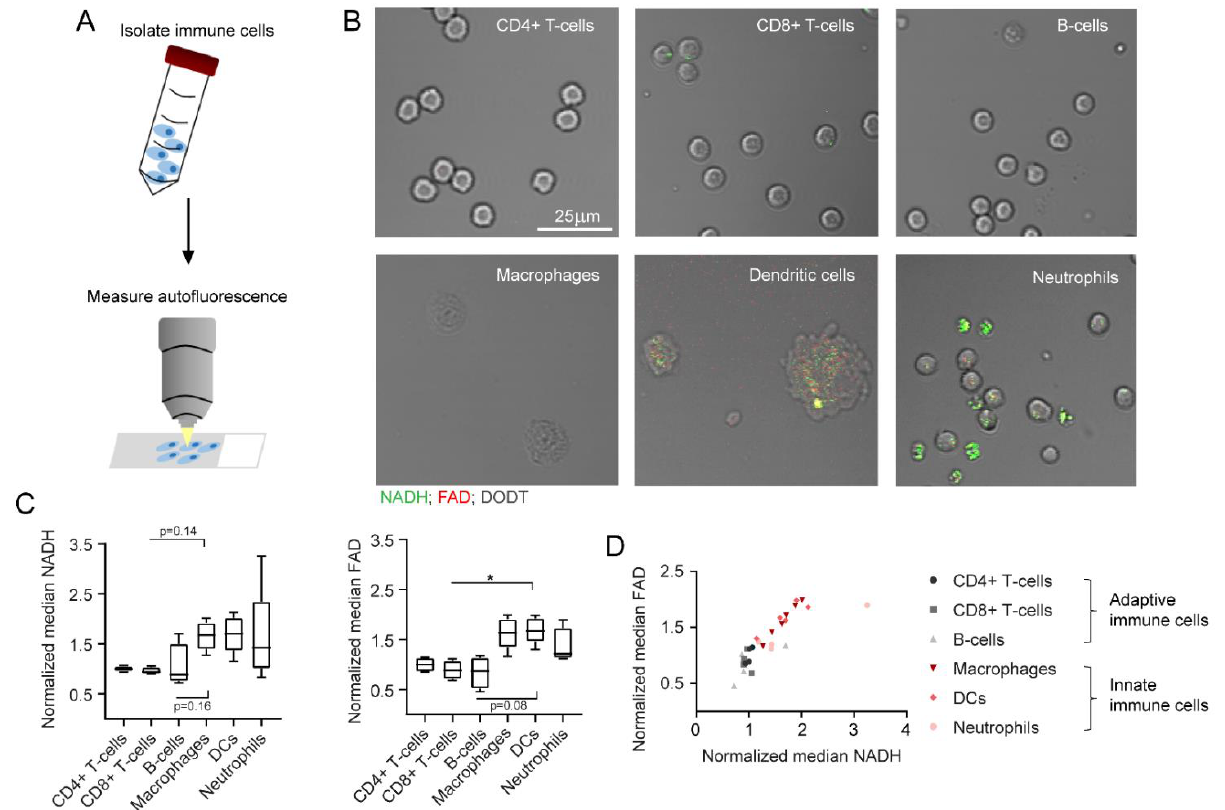
Figure 4. NADH and FAD autofluorescence changes as measured in multiphoton microscopy. ( A ) Schematic representation of MPM measurements after immune cell isolation from murine spleen and bone marrow. ( B ) Exemplary images of different immune cell types, as measured in MPM. NADH: green, FAD: red, DODT: grey (scalebar: 25 µm). ( C ) Median NADH and FAD signals of different immune cells, normalized to NADH and FAD signals of alive, unstimulated CD4+ T cells. For statistical analysis, a Kruskal – Wallis test with Dunn’s multiple comparisons test was used (* p < 0.05). At least four samples per group were analysed. Each sample includes at least 30 – 500 cells and reflects either cells isolated from one mouse (CD4+ T cells, CD8+ T cells, B cells, neutrophils) or cells cultured in one culture dish (macrophages, dendritic cells). ( D ) Comparison of normalized median NADH and FAD